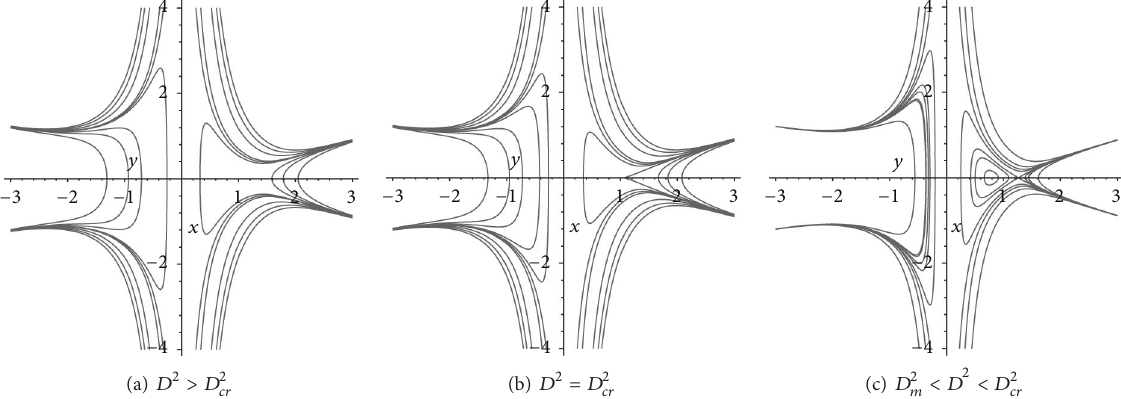
Figure 7: The phase portraits of system (6) for 𝑛 = 2𝑚 + 1 , 𝛽 > 0 , 𝐺 1 > 0 , and 𝜎 < 0 .